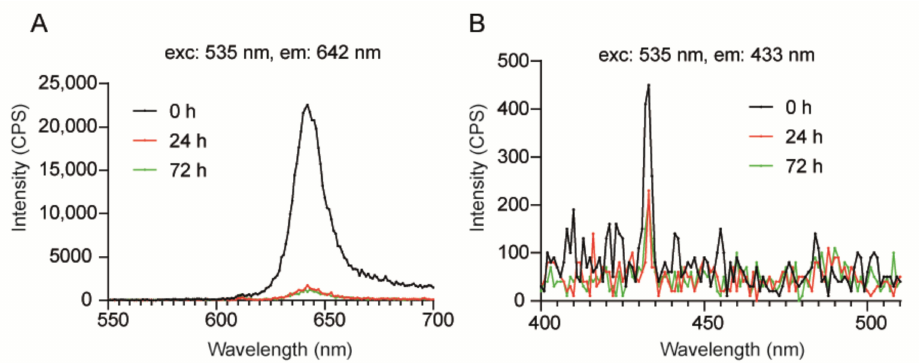
Figure 7. Assessment of optical properties of TTA-UC-PLGA-NPs in solution. TTA-UC-PLGA-NPs were dissolved in water and incubated at 37 ◦ C for 72 h. At time point 0, 24 and 72 h, samples were analysed. The NPs in solution were excited at 535 nm, and the emission was collected using a photofluorometer. ( A ) Phosphorescence and ( B ) TTA-UC emission graphs of TTA-UC-PLGA-NPs at various time